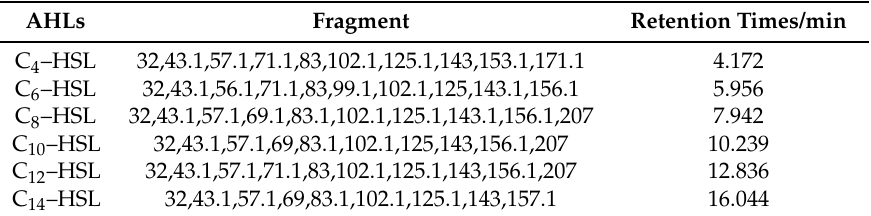
Table 2. The SIM parameter of six kinds of AHLs.